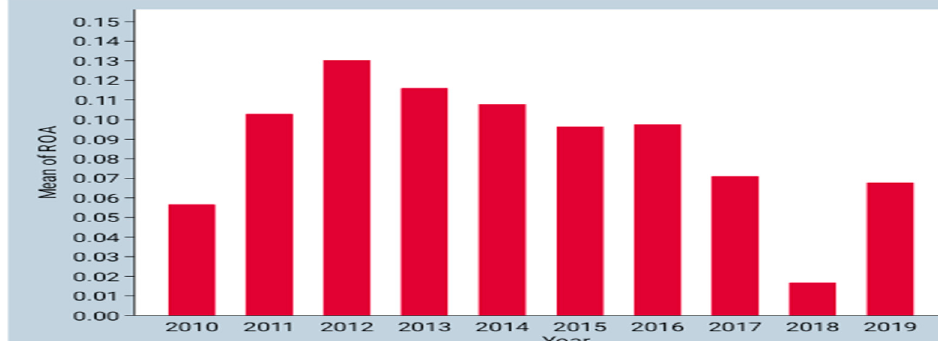
Figure 2. Trends in return on assets.